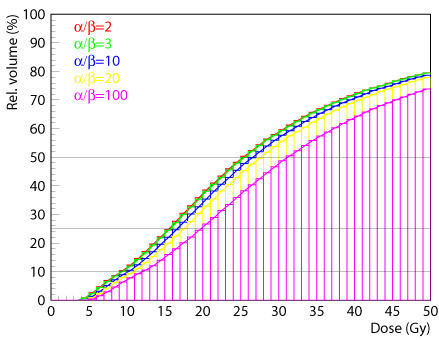
Based on the total 3D-Dtot-data set, Amira software calculated dose-volume histograms for all different α/β-values.